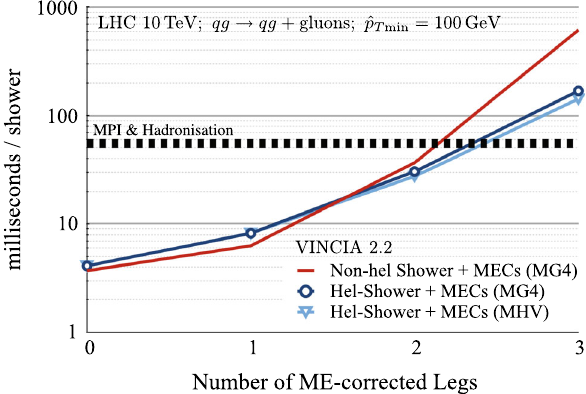
Fig. 1 Speed comparison for helicity-independent (“Non-hel”) and helicity-dependent (“Hel”) showers as a function of the number of ME- corrected legs, for qg → qg + gluons with ˆ p ⊥ min = 100GeV, for pp collisions at E cm = 10TeV. The dashed horizontal line indicates the time it takes to generate MPI and hadronisation for the same events. Results were obtained from 10,000 events generated for each run, on a single 2.9 GHz Intel Core i7 processor, using the clang compiler (v3.9), with -O2